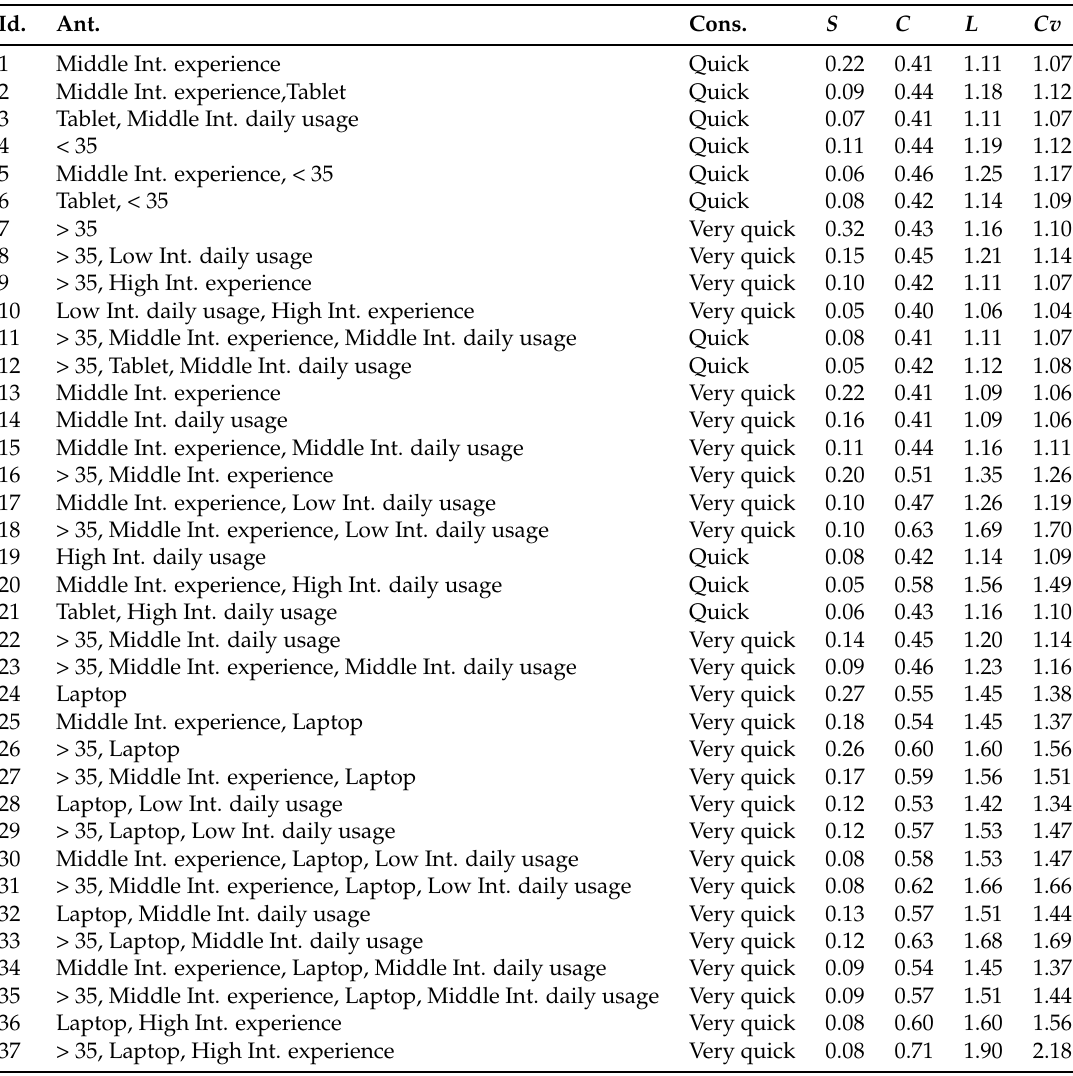
Table 2. The set of the extracted association rules for Dice 2 CAPTCHA. The number of attempts in the consequent is 1 for all ARs (consequently, it is